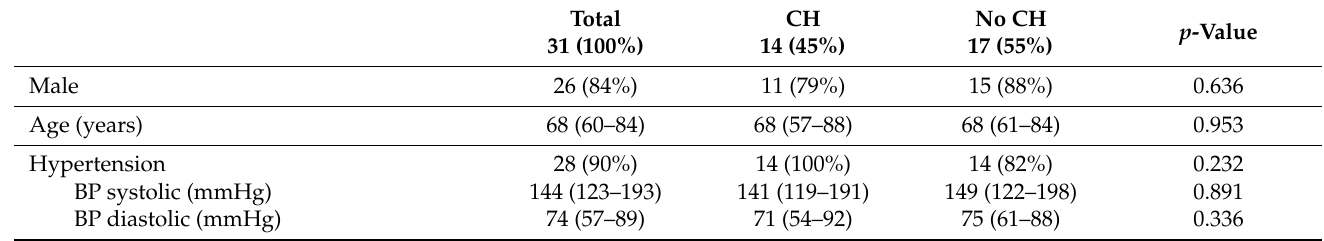
Table 1. Characteristics of patients with peripheral artery disease (PAD). The p -values describe the comparison of patients with CH mutations and without CH mutations and were calculated using Chi-square test (categorical variables, presented as number and percentage) or Mann–Whitney U-test (numerical variables, presented as median and inter quartile range). CLTI—critical limb- threatening ischemia, COPD—chronic obstructive pulmonary disease, CRP—C-reactive